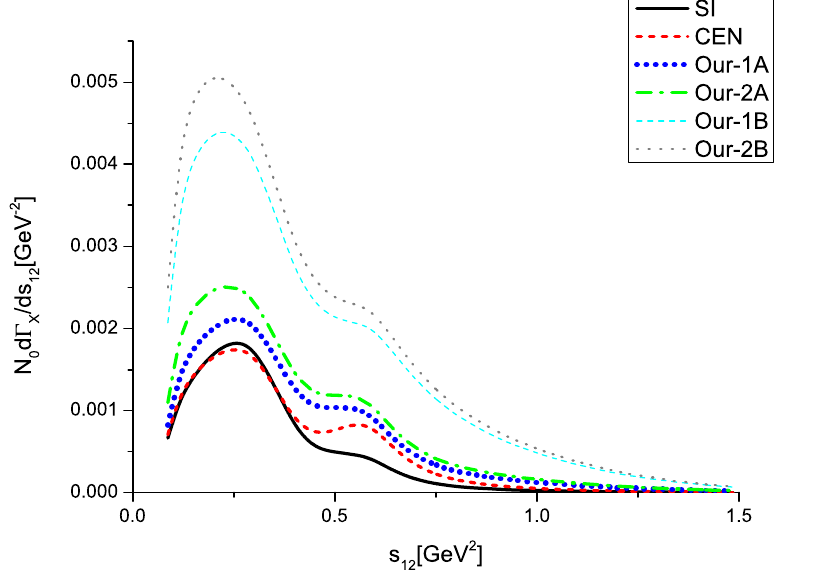
Figure 6 . Invariant-mass distributions of the ππ with E cut = 0 . 3 GeV. The normalization factor is γ taken as N 0 = 1 / Γ . The meanings of different curves are the same as those in figure 5. τ − → π − π 0 ν τ